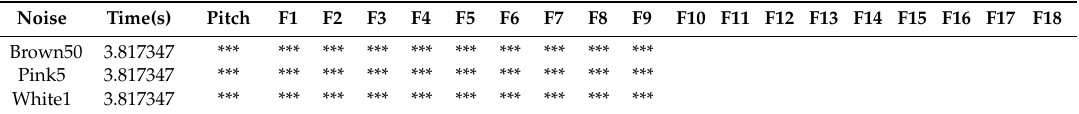
Table 8. The result of audios confrontation undergone with insertion of di ff erent levels of noise (Sentence #1 for suspect